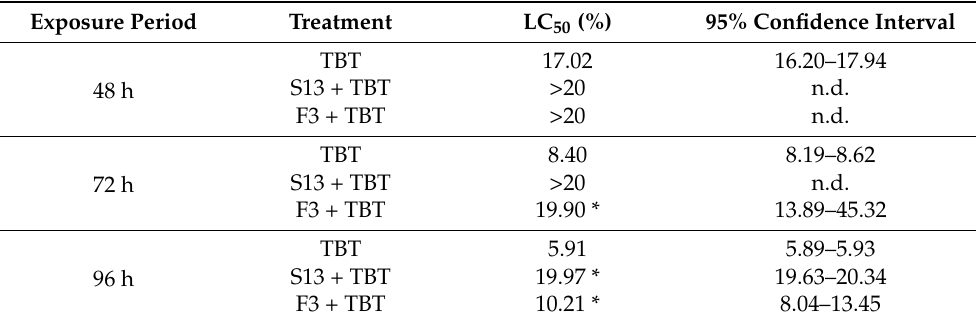
Table 1. Lethal concentration values estimated for Gibbula umbilicalis exposed to untreated and bioremediated media. Strain S13: Pseudomonas putida ; Strain F3: Serratia marcescens . Asterisk (*) indicates significant differences in LC 50 between bioremediated treatments and untreated